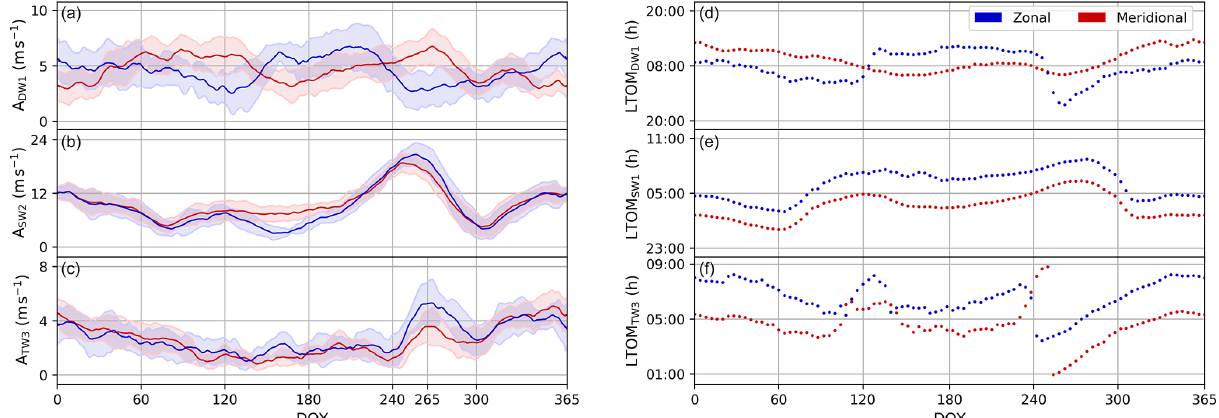
Figure 4. Climatologies of the amplitude (a–c) and phase (d–f) of the DW1 (a) , SW2 (b) , and TW3 (c) based on SuperDARN meridional (red) and zonal (blue) meteor winds between the years 2000 and 2016. Shading marks the standard deviation around the climatological mean. The amplitude of TW3 on DOY 265, referenced extensively in the text, is indicated in (c) .